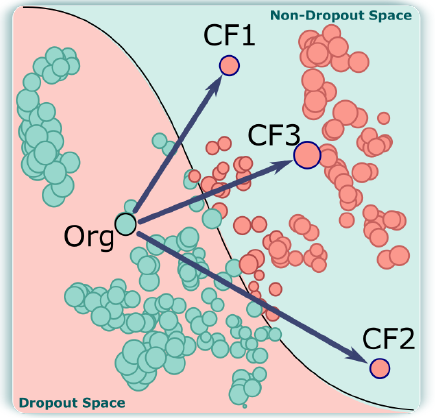
Figure 1. Example of the concept of explanation antecedents. The representation shows the decision boundary of a classifier, where a green dot (in the dropout space of the boundary) named Org is affected by changes (represented by the arrows), creating counterfactual instances (red dots) named CF1, CF2, and CF3 in the non-dropout space of the